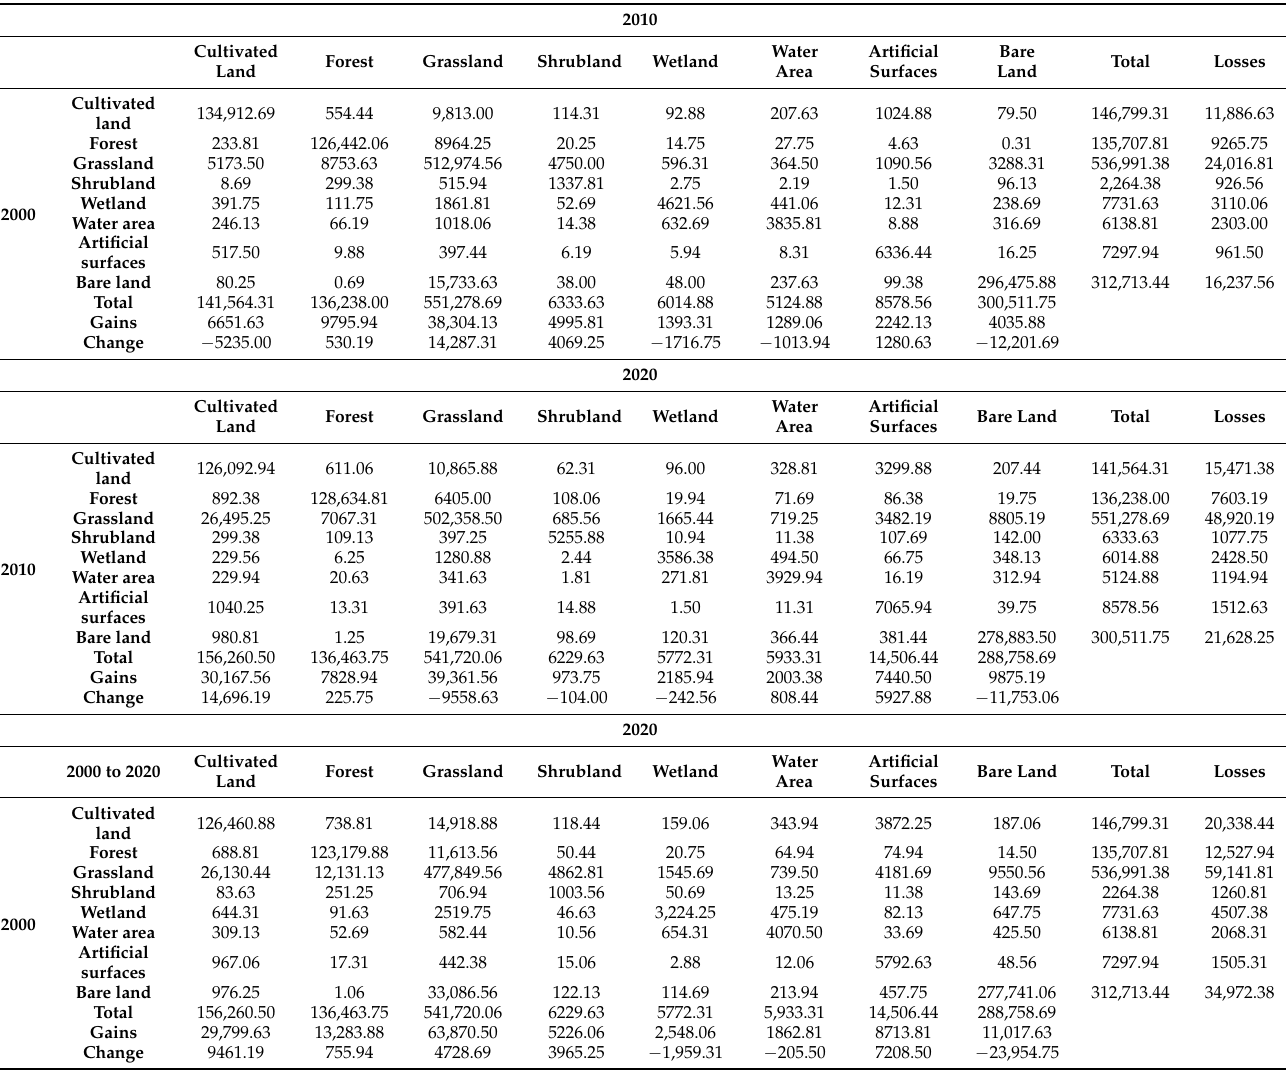
Table 4. Transition matrices for the land-use/land-cover change in 2000–2010, 2010–2020, and 2000–2020 in Inner Mongolia (unit: km 2